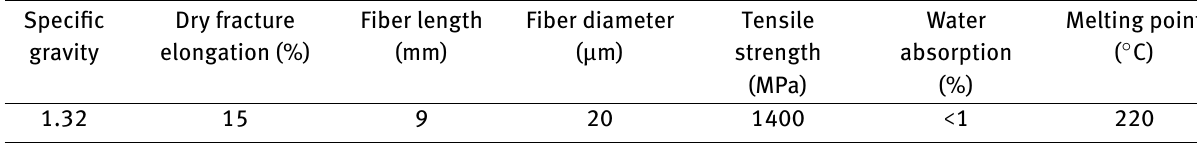
Table 3: Physical properties of nano-SiO 2 Average